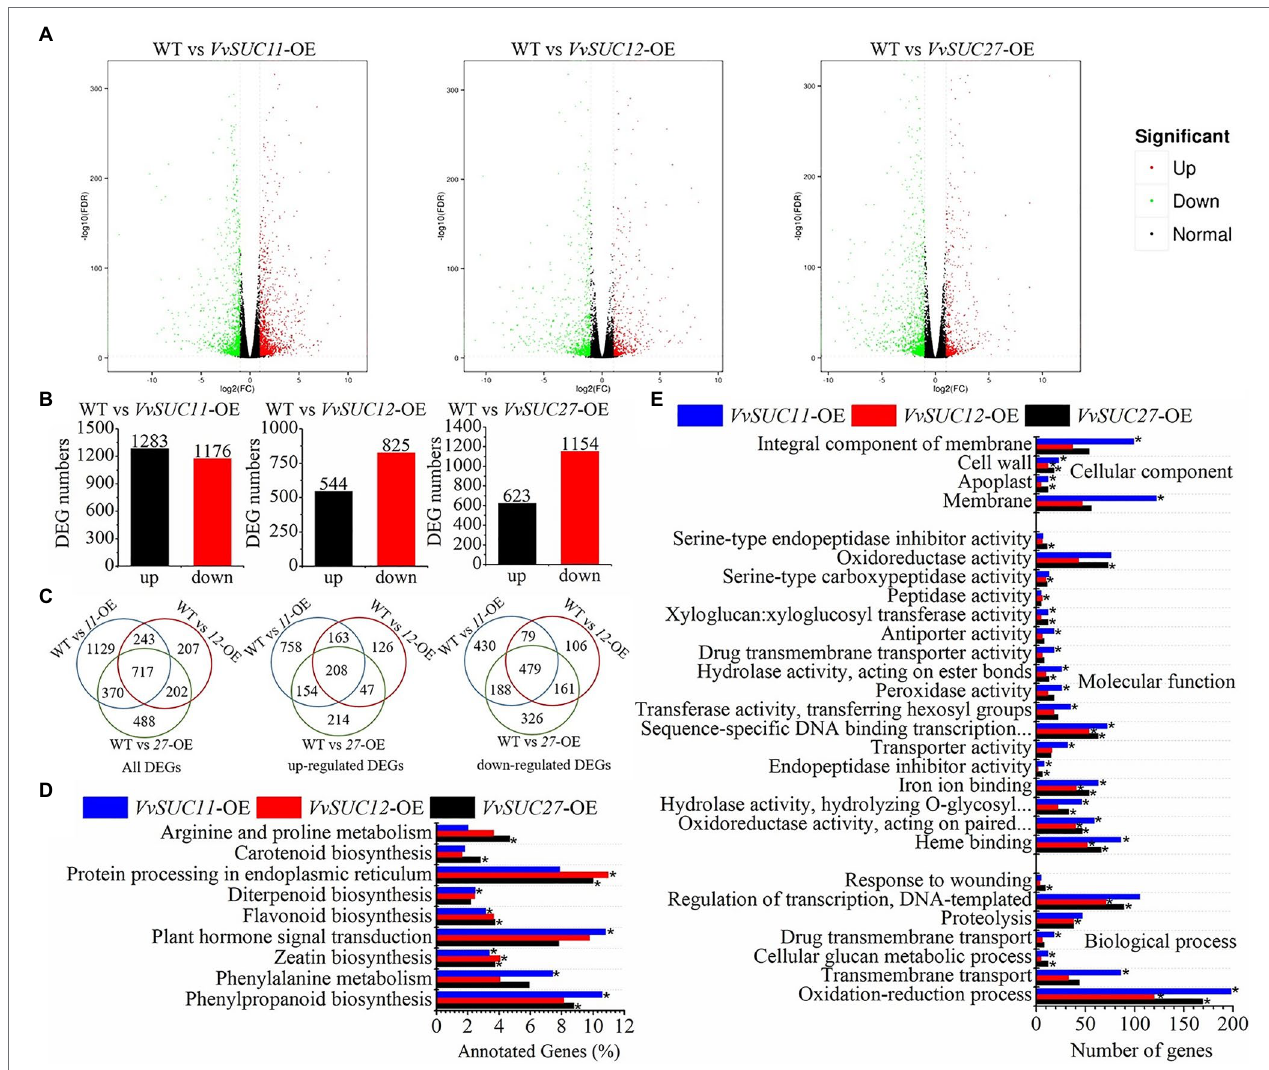
FIGURE 6 | Analyses of differentially expressed genes (DEGs) in VvSUC -OE fruits. | log 2FoldChange | > 1 and FDR < 0.01 were used as thresholds to select the DEGs. (A) Volcano diagrams of DEGs in VvSUCs- OE fruits compared with WT fruits at 5 DPA. Green spots indicated DEGs whose expression was less than half that of the WT. Red spots displayed DEGs whose expression was more than double that of the WT. (B) Number of up- and downregulated DEGs in each VvSUC -OE fruit compared with that of the WT. (C) Venn diagrams showing all, upregulated, and downregulated DEGs that were commonly expressed in VvSUC11 -, VvSUC12 -, and VvSUC27 -fruits compared with that of the WT, respectively. (D) KEGG pathway enrichment analysis of DEGs in 5 DPA tomato fruits of VvSUCs -OE lines. *indicates a significantly enriched term (corrected value of p < 0.05). (E) GO enrichment analysis of DEGs in 5 DPA tomato fruits of VvSUCs -OE lines. “Oxidoreductase activity, acting on paired…,” “Hydrolase activity, hydrolyzing O-glycosyl…,” and “Sequence-specific DNA binding transcription…” were short for “Oxidoreductase activity, acting on paired donors, with incorporation or reduction of molecular oxygen, NAD(P)H as one donor, and incorporation of two atoms of oxygen into one donor,” “Hydrolase activity, hydrolyzing O-glycosyl compounds,” and “Sequence-specific DNA binding transcription factor activity.” *indicates a significantly enriched term (corrected value of p <